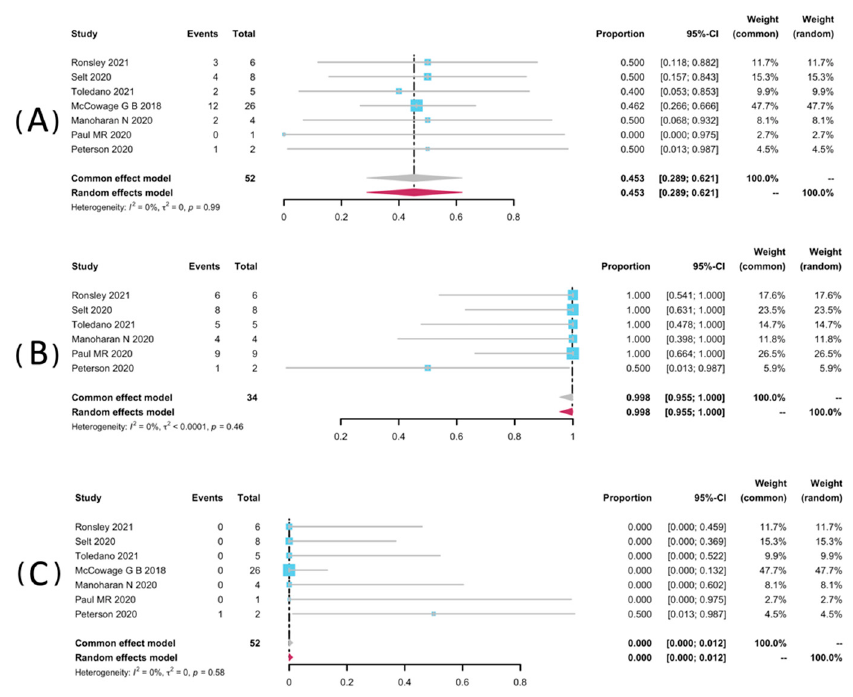
Figure 2. Forest plots for the objective response rate ( A ), the disease control rate ( B ), and the progression rate ( C ) in patients receiving trametinib.